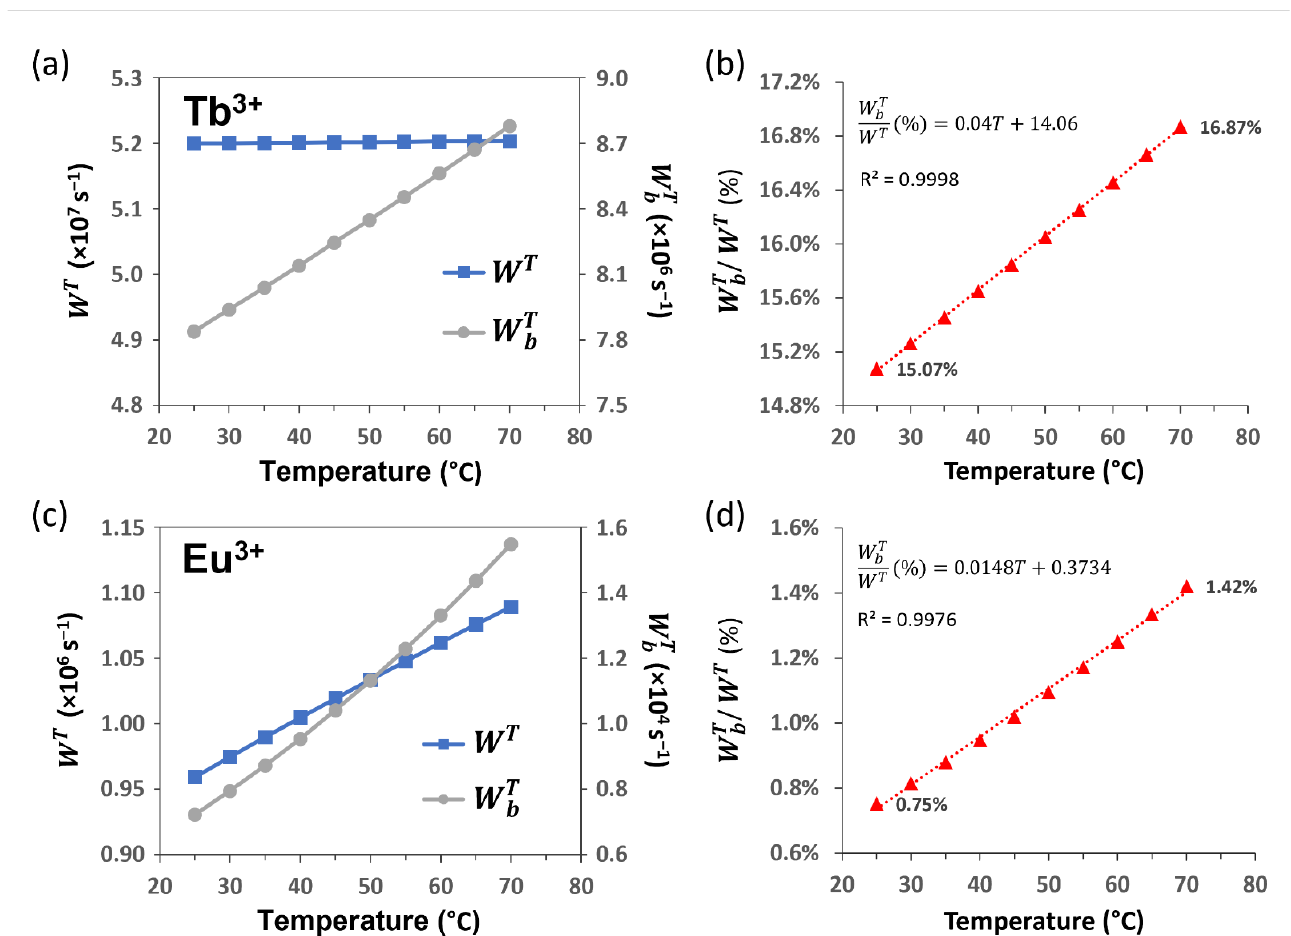
Figure 7. IET rates involving the ligand T 1 state. Forward W T and backward W T ( c ) Eu 3+ complexes (in s − 1 ) as a function of the temperature; ( b , d ) show the growing behavior of the W T regarding the W T with temperature.